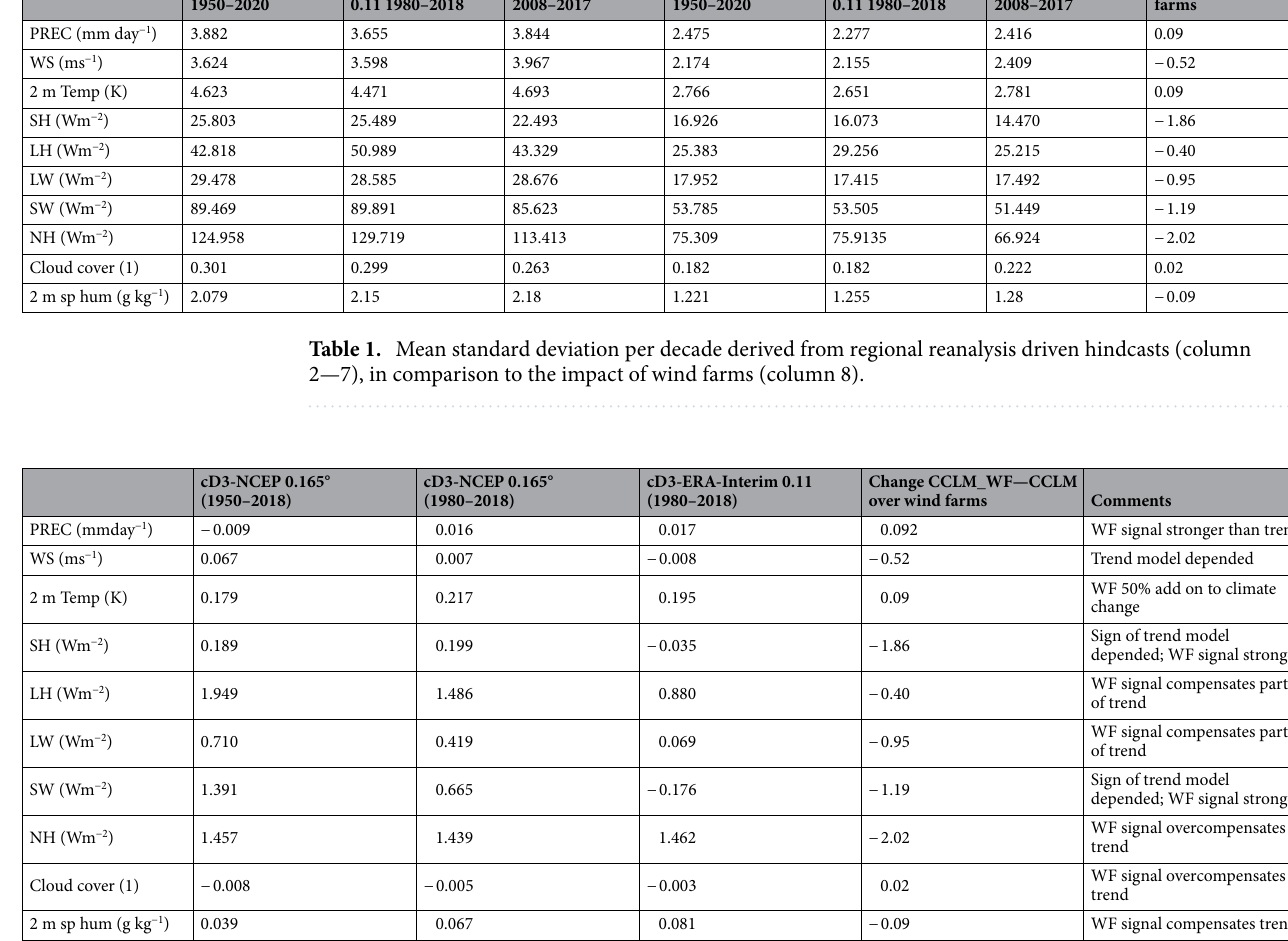
Table 2. Trends per decade (1950–2018 and 1980–2018) derived from regional reanalysis driven hindcasts (column 2—4) , in comparison to the impact of wind farms (column 5) over the North Sea. SH, LH, LW and NH are defined positive upward, SW positive